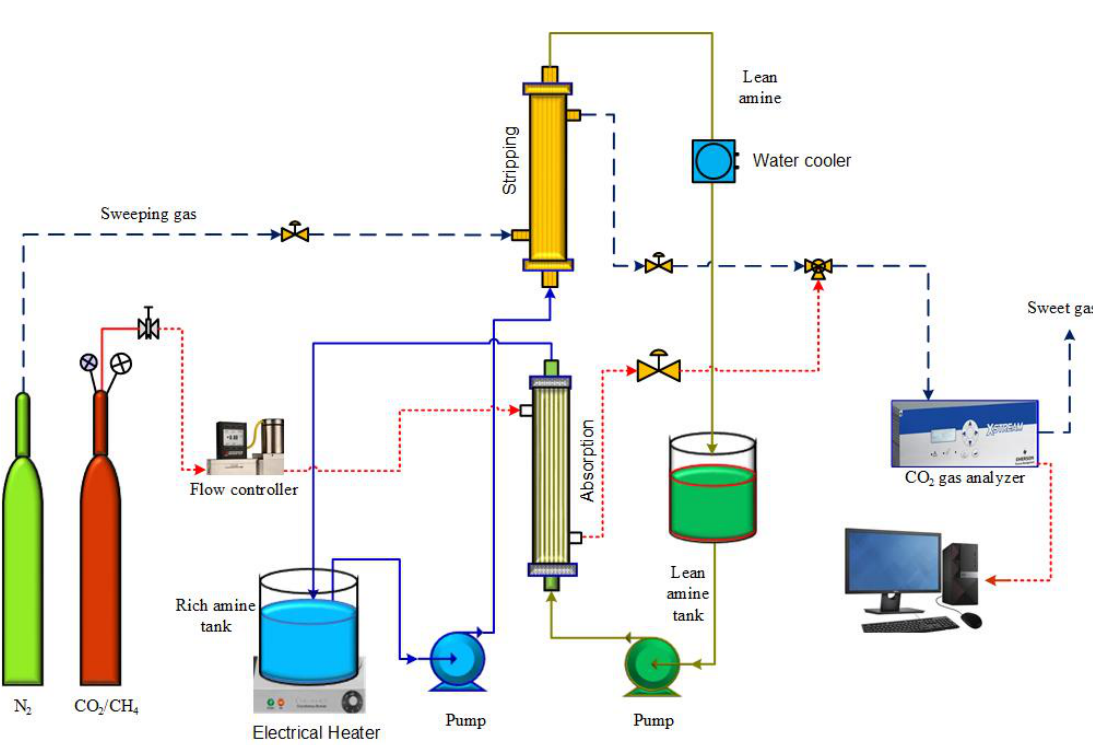
Figure 1. Schematic of the absorption/stripping process using a gas–solvent membrane system. Table 1. Dimensions membrane module [1].